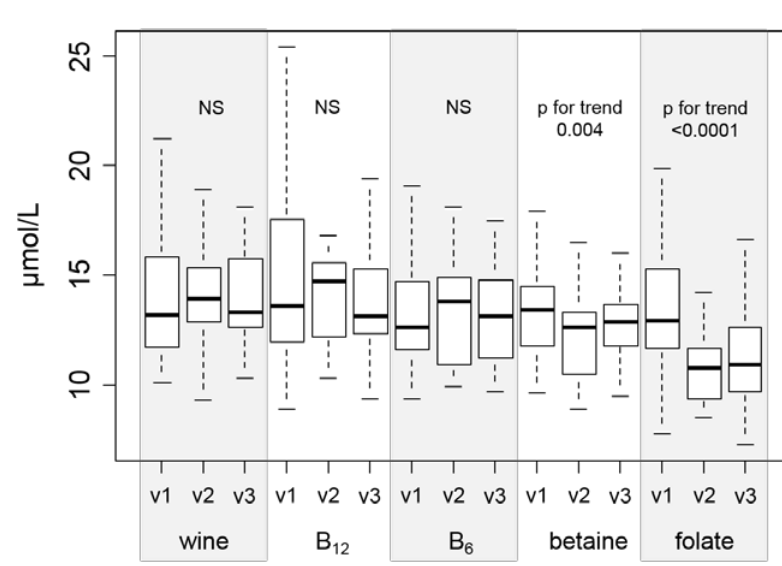
Figure 2. Serum total Hcy concentration in all groups, and visit 1 (v1), visit 2 (v2), and visit 3